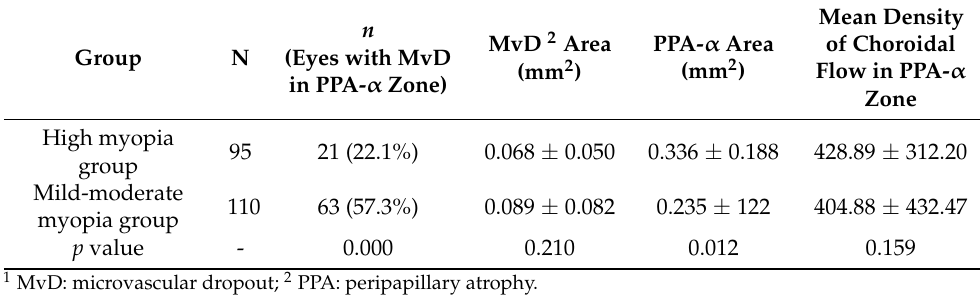
Table 2. Characteristics of participants having MvD 1 in PPA 2 - α zone.